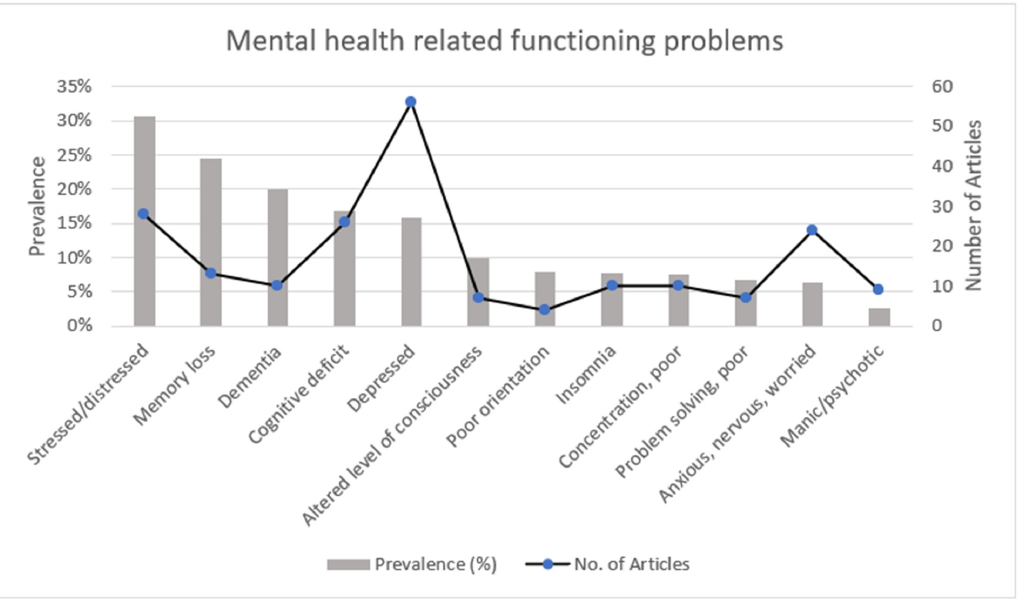
Figure 5. Prevalence of, and number of articles reporting on, mental health related functioning prob- lems.